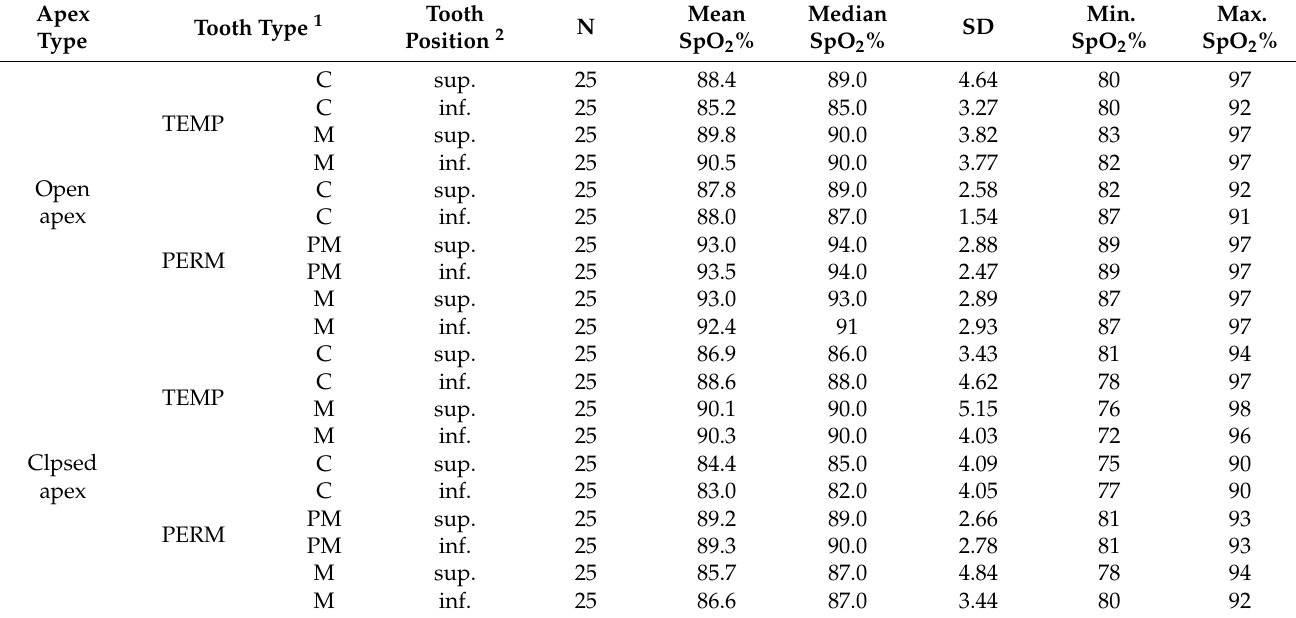
Table 6. SpO 2 values of primary and permanent teeth by tooth type and